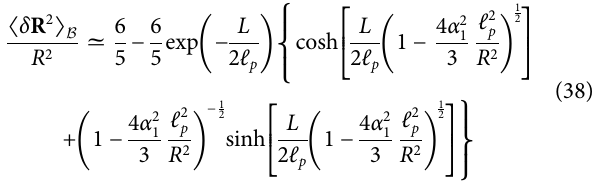
Frontiers in Physics |